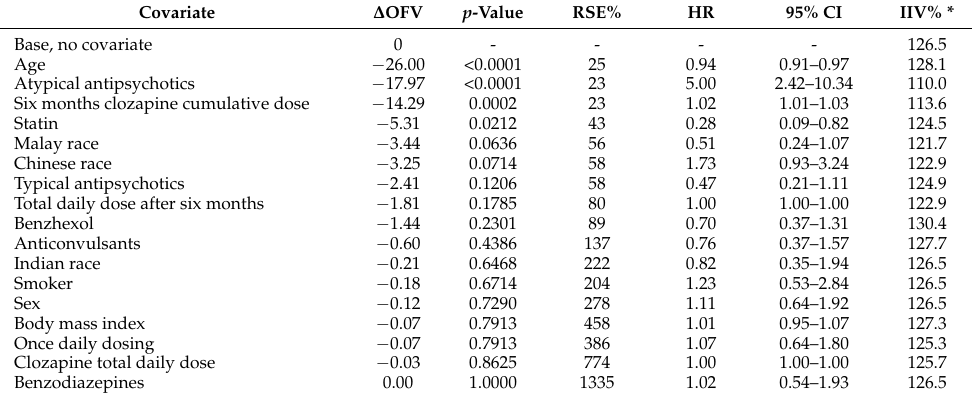
Table 3. Univariate analysis of covariate effects on the hazard of improving symptoms among Malaysian patients with schizophrenia spectrum disorders (n =